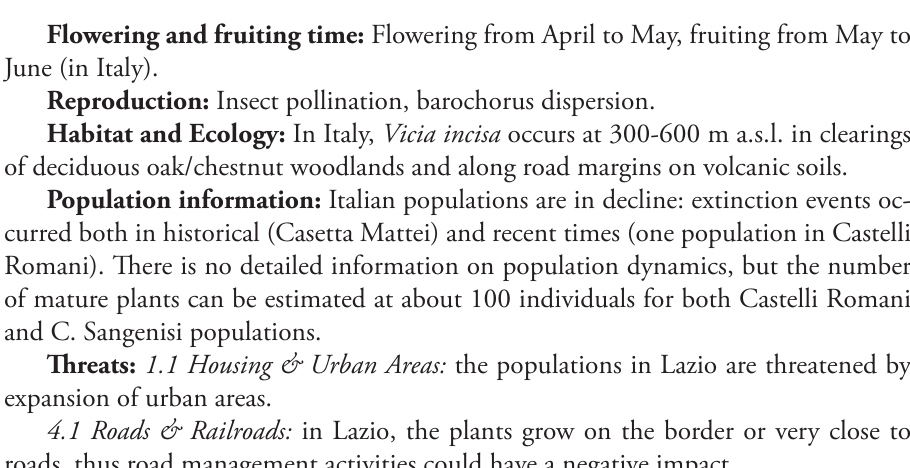
Flowering and fruiting time: Flowering from April to May, fruiting from May to June (in